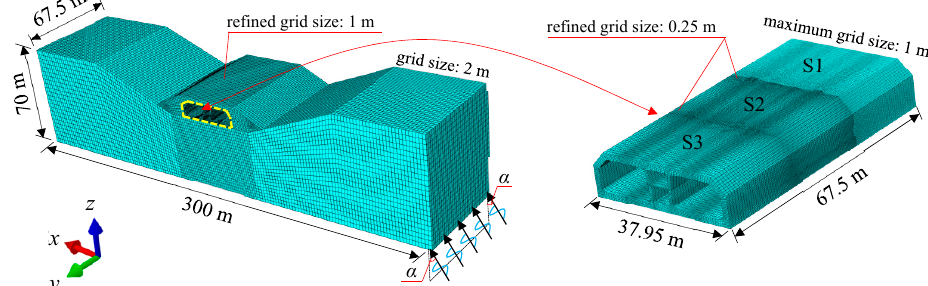
Figure 8. Whole FE model.